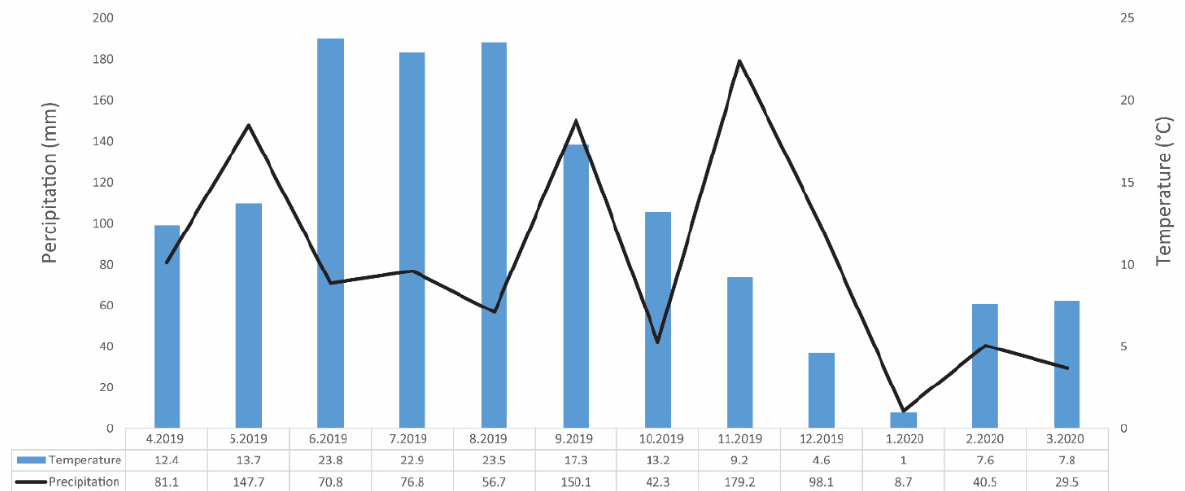
Figure 1. The average monthly precipitation and temperature at experimental field of Virginia mallow (Maksimir, elevation 123 m, 45°49′48″ N 16°01′19″ E).